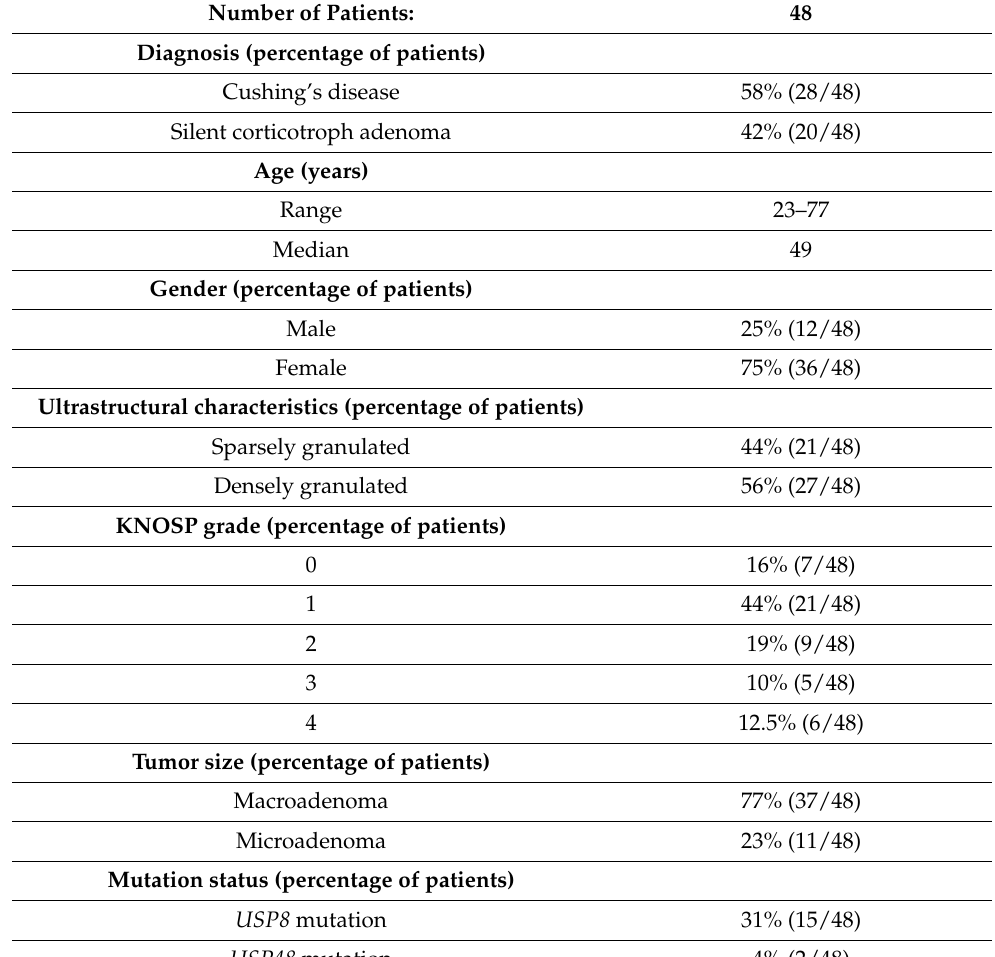
Table 1. Patients’